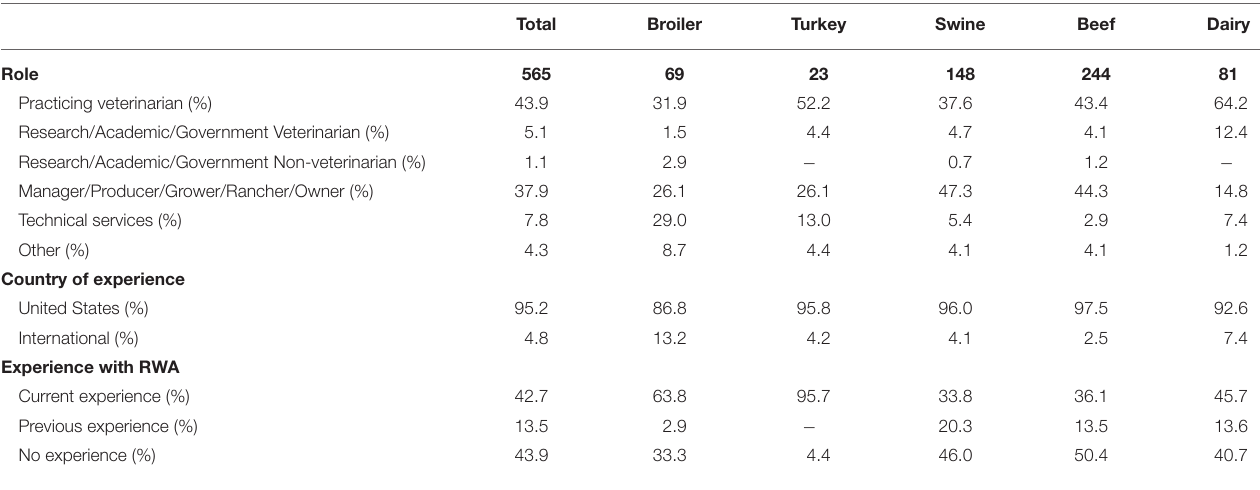
TABLE 1 | Characteristics of survey respondents, n =